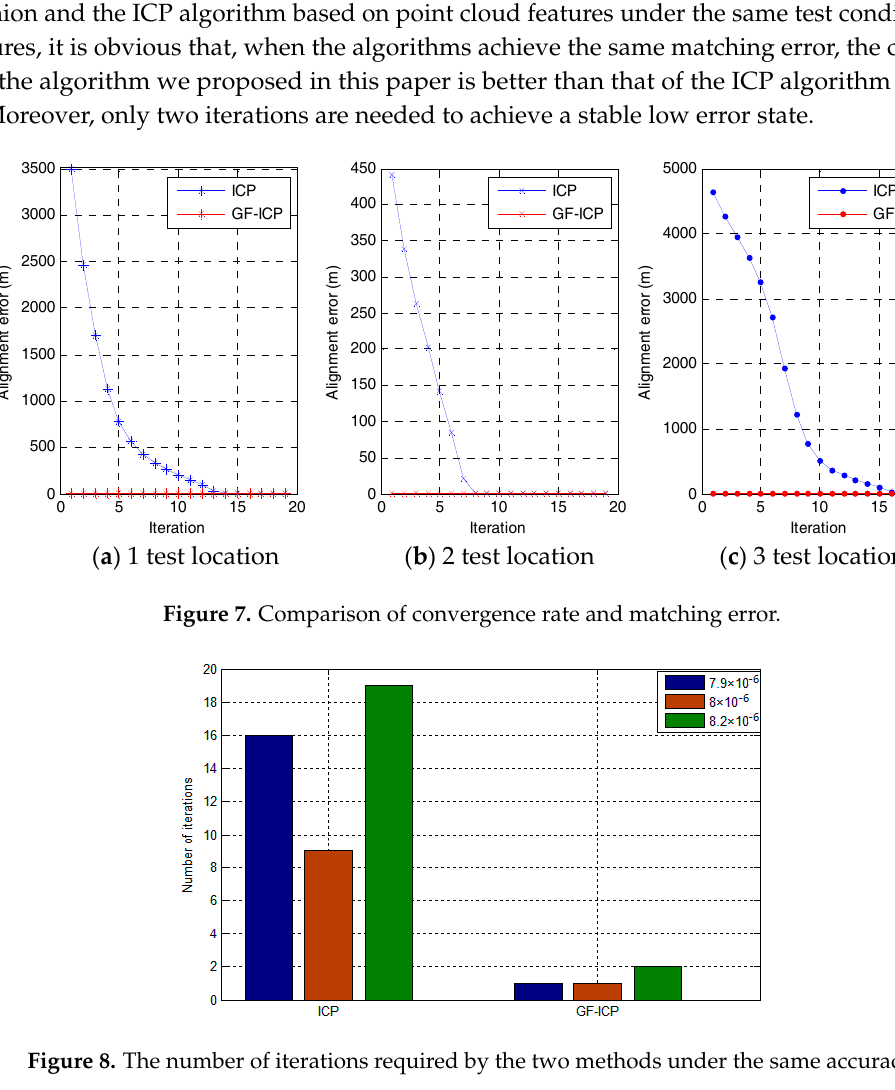
Figure 6. The results of three point cloud matching algorithms.